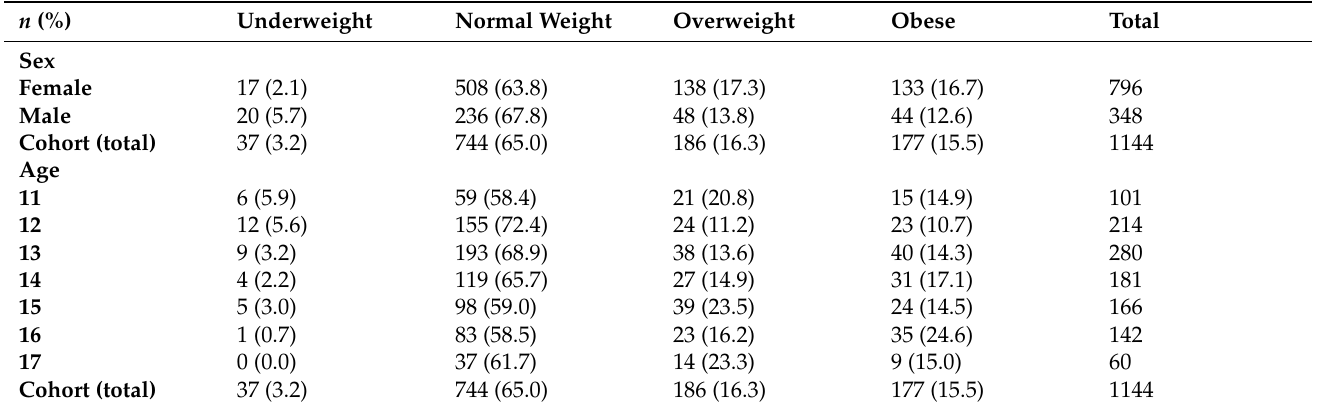
Table 3. Body weight classification by BMI percentile split by age and sex.